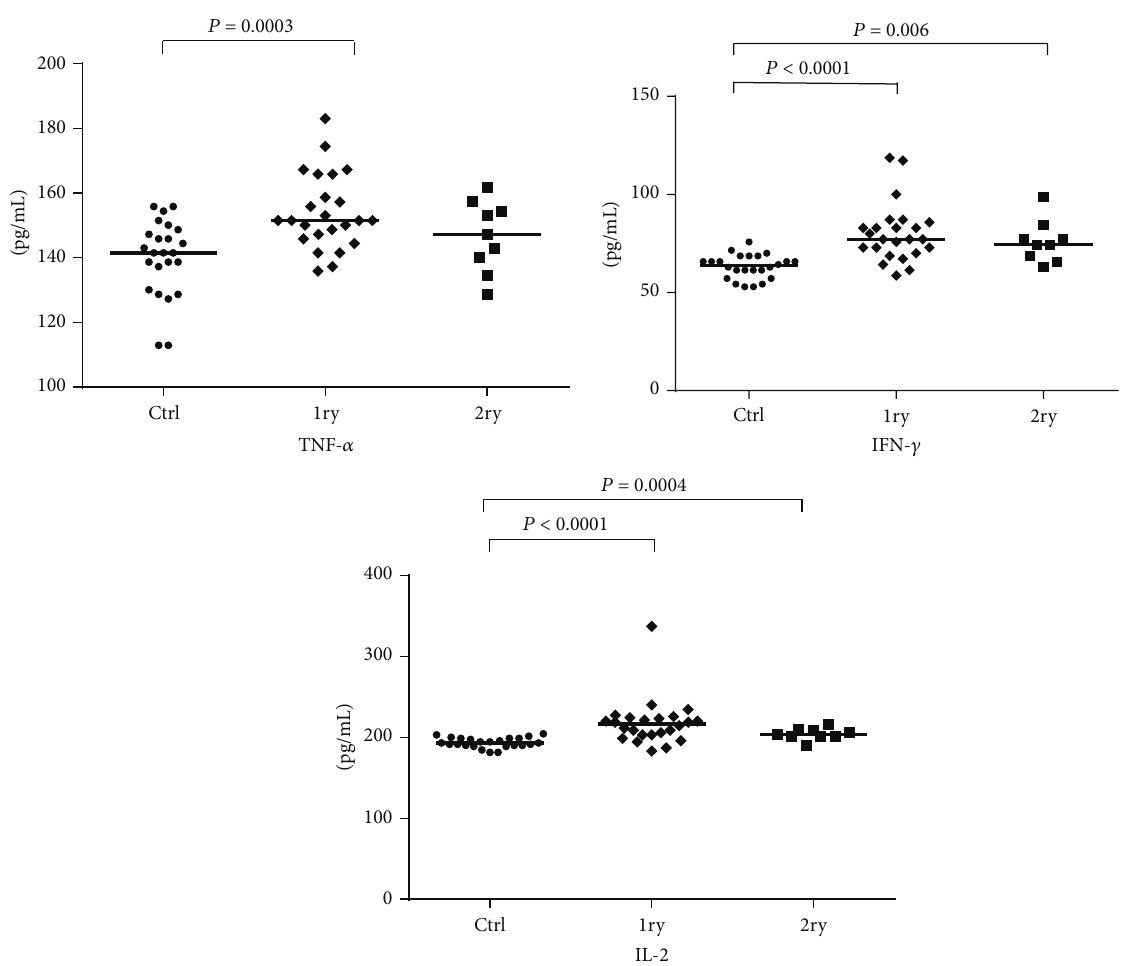
Figure 3: IL-2, TNF- 𝛼 , and IFN- 𝛾 levels in sera obtained from individuals with primary or secondary Leishmania infections and from noninfected controls. Cytokine levels (pg/mL) were calculated for each serum sample. Means (horizontal lines) are shown for each group. Ctrl: noninfected controls; 1ry: primary infections; 2ry: secondary